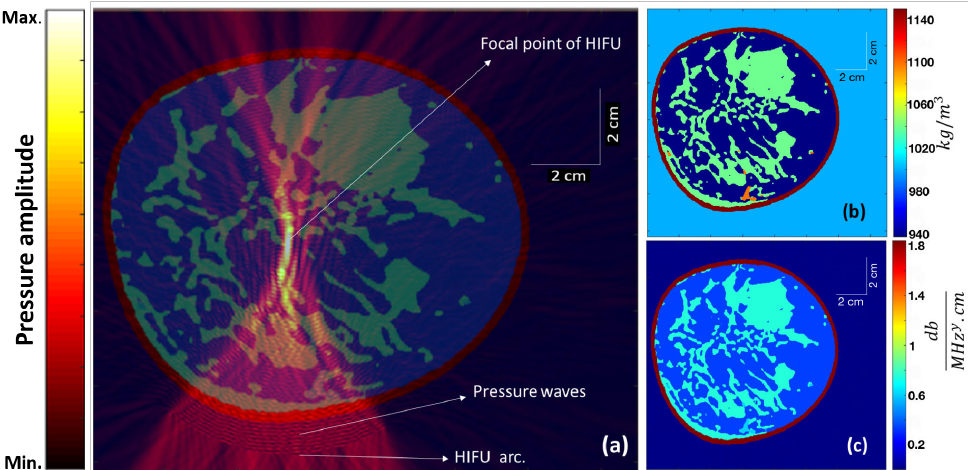
Figure 2. ( a ) The steady-state instantaneous pressure wave amplitude (from the HIFU) overlayed on the cross-section of an extremely dense breast. ( b ) The mass density distribution map and ( c ) the acoustic attenuation coefficient map corresponding to different tissue structures within the